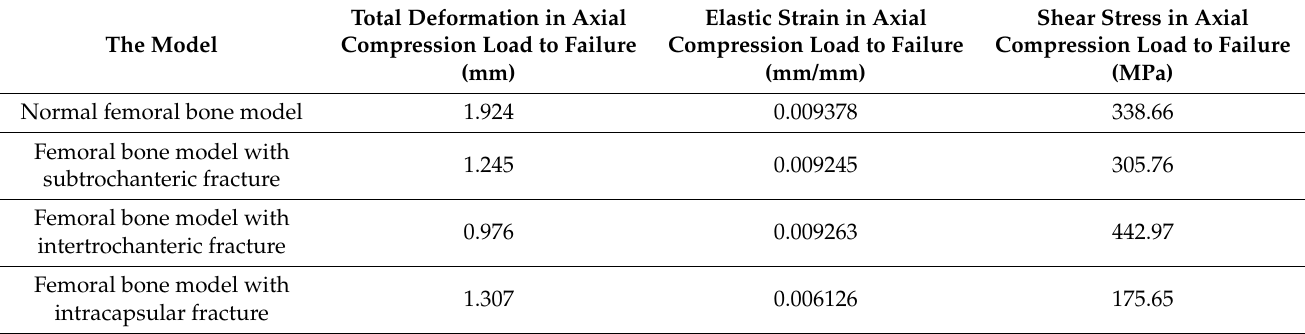
Table 11. Max deformation, strain, and shear in axial compression load to failure scenario.